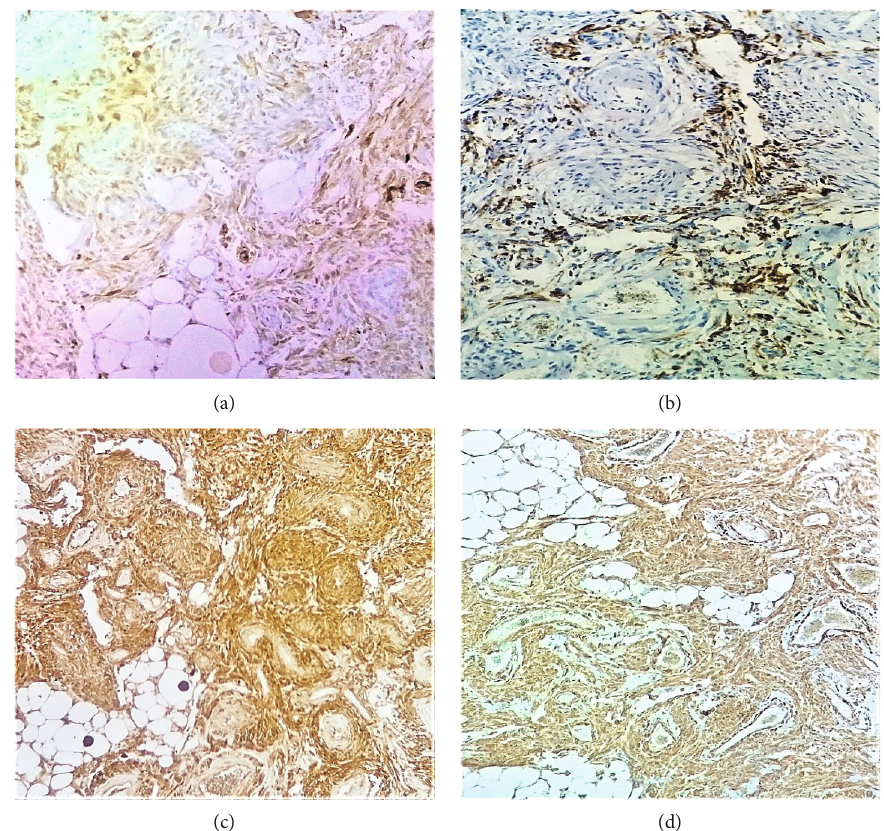
Figure 4: Immunohistochemical study of the AML showing the positivity of (a) Melan A, (b) HMB45, (c) H-Caldesmon, and (d) smooth muscle